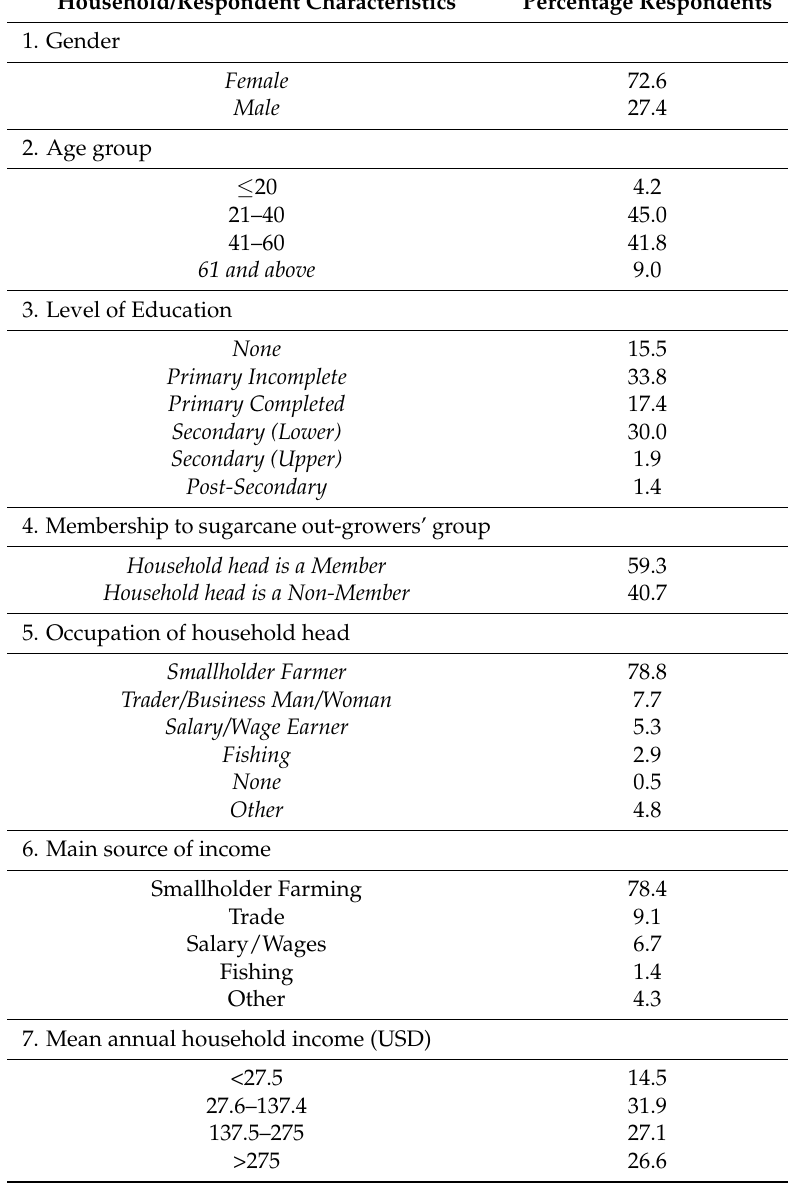
Table 1. General household characteristics based on results from questionnaire interviews with respondents ( n = 208) from Mayuge and Jinja Districts. 1USD = 3640UGX (Uganda